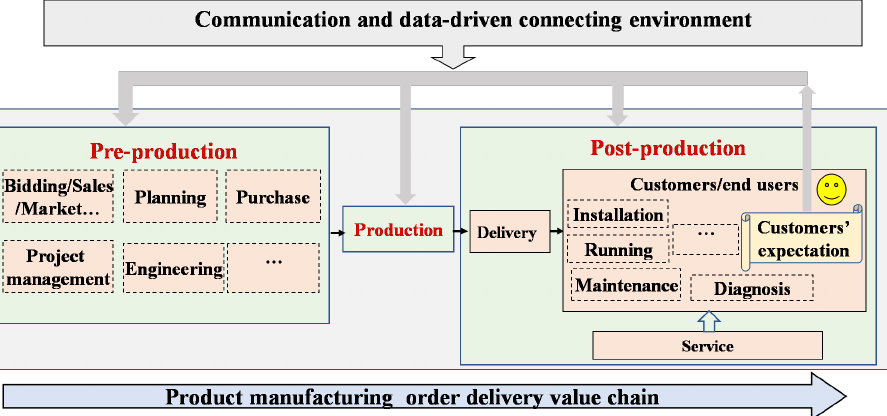
Figure 1. Manufacturing focused process for customer order delivery through the enterprise business value